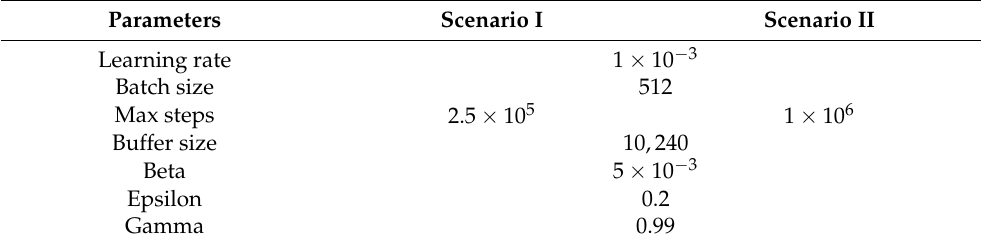
Table 2. Learning Parameters.